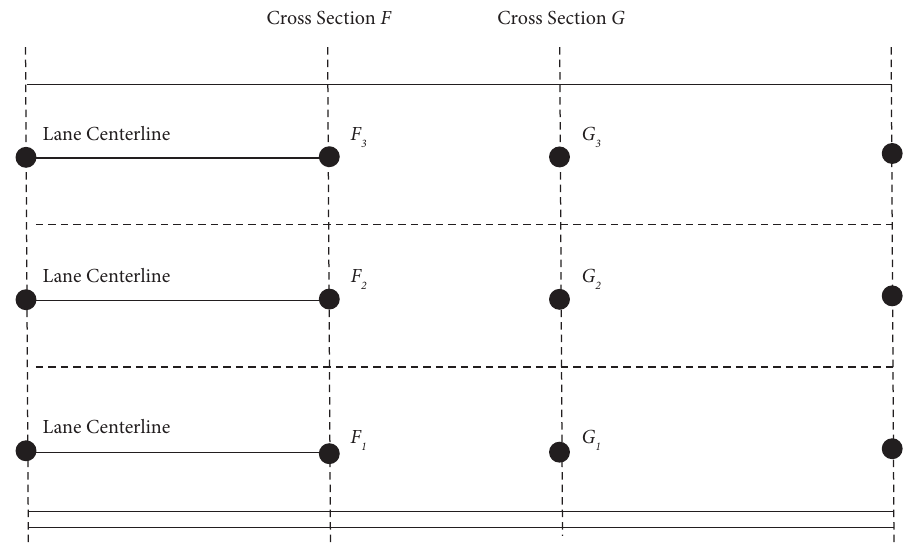
Figure 6: Lane centerline node